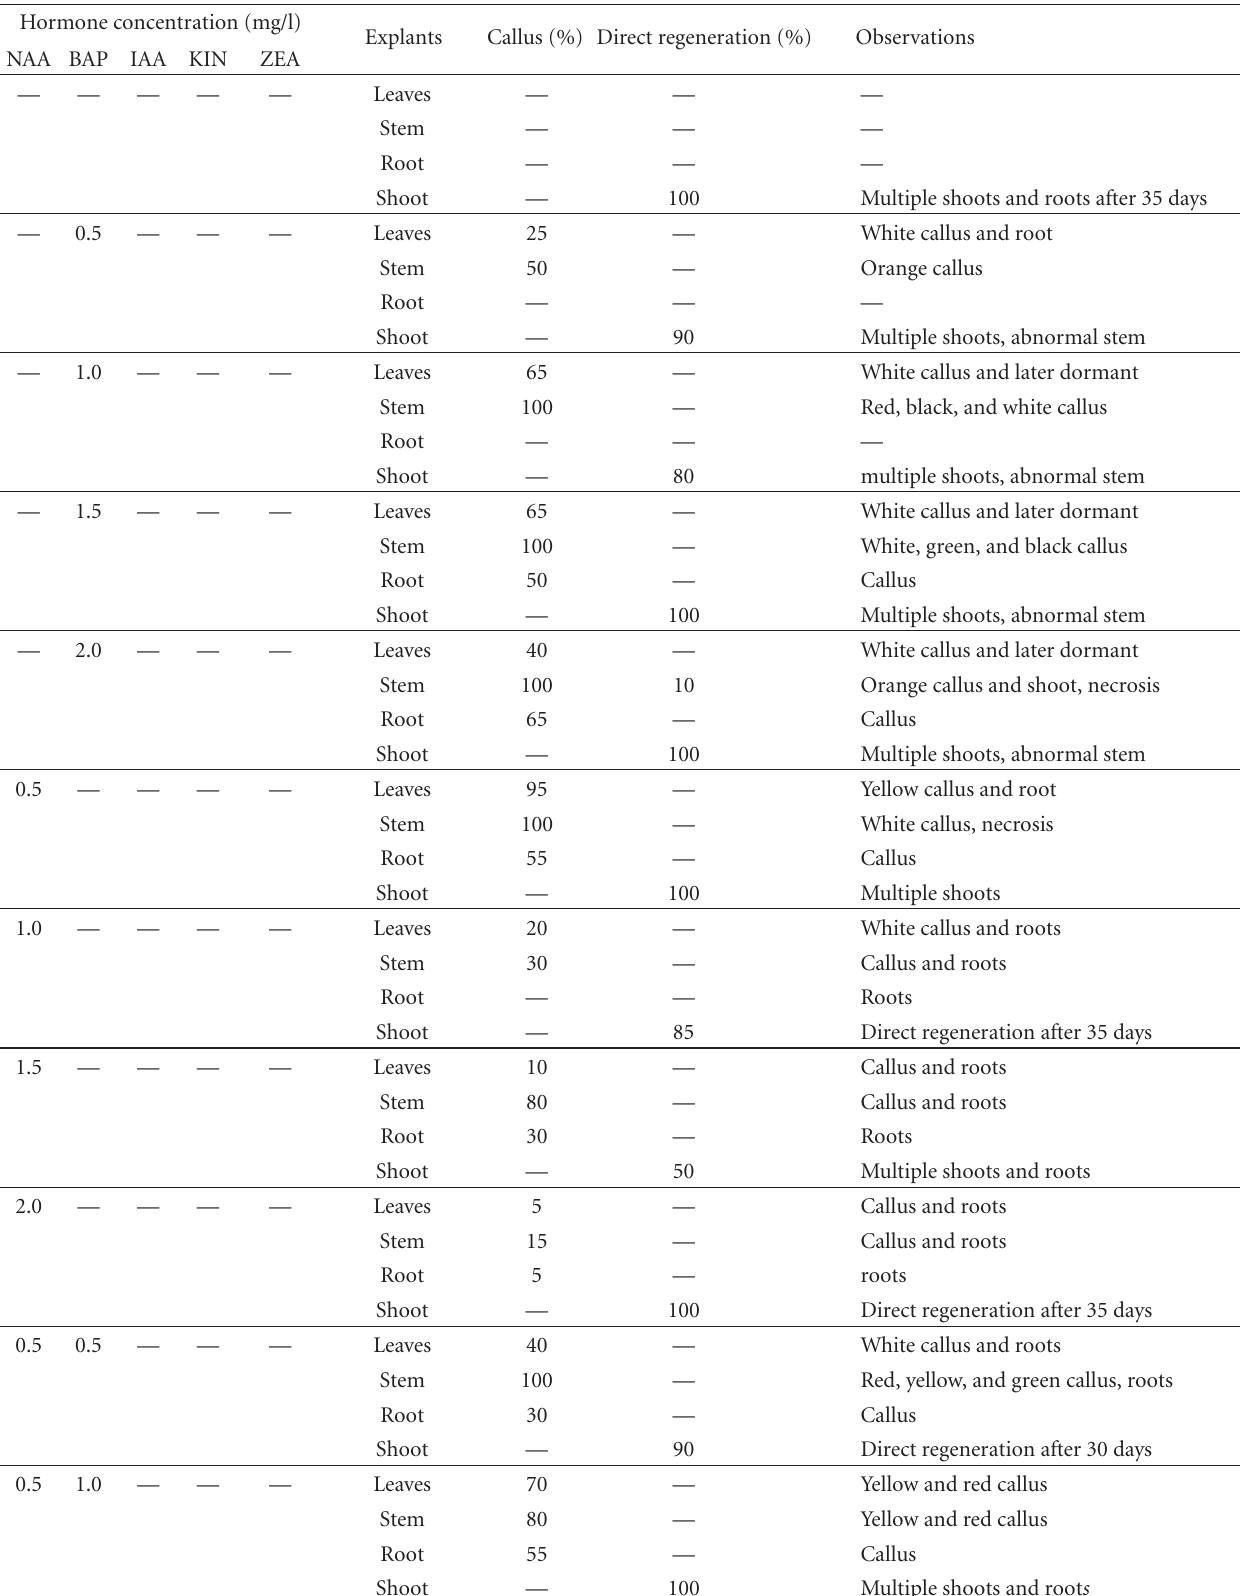
Table 1: E ff ects of di ff erent hormones on the tissue culture of Celosia cristata initiated from various explants maintained at 25 ± 1 ◦ C with 16h light and 8h